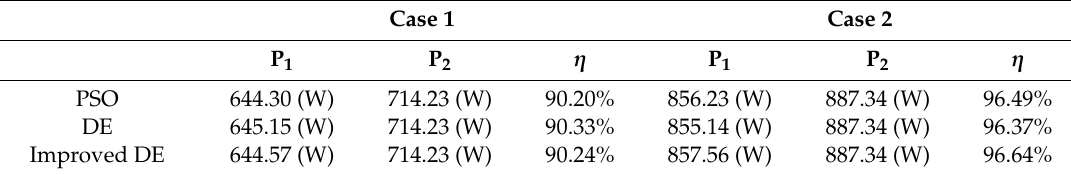
Table 3. Comparisons of MPPT e ffi ciency of the three